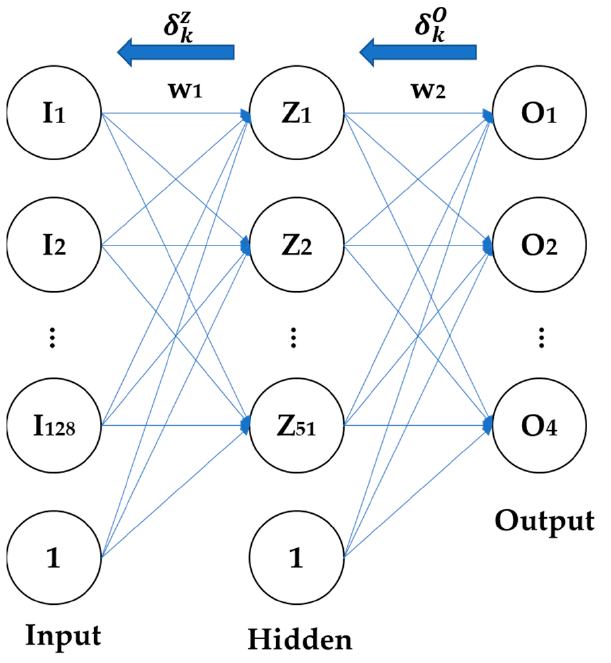
Figure 10. The structure of the backpropagation algorithm.